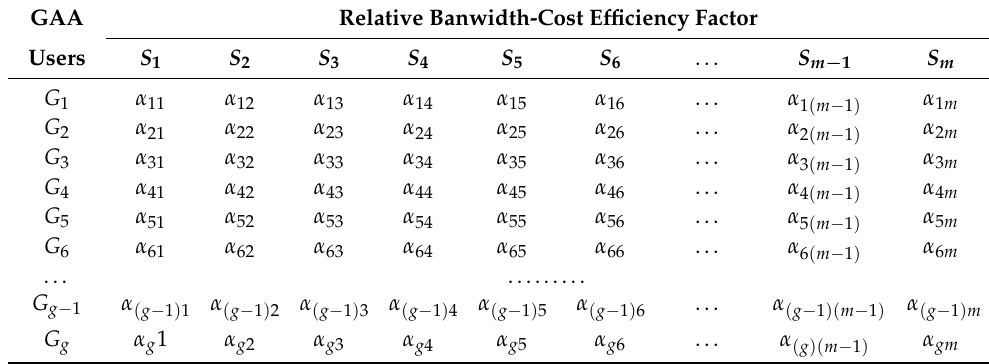
Table 5. Relative bandwidth-cost efficiency